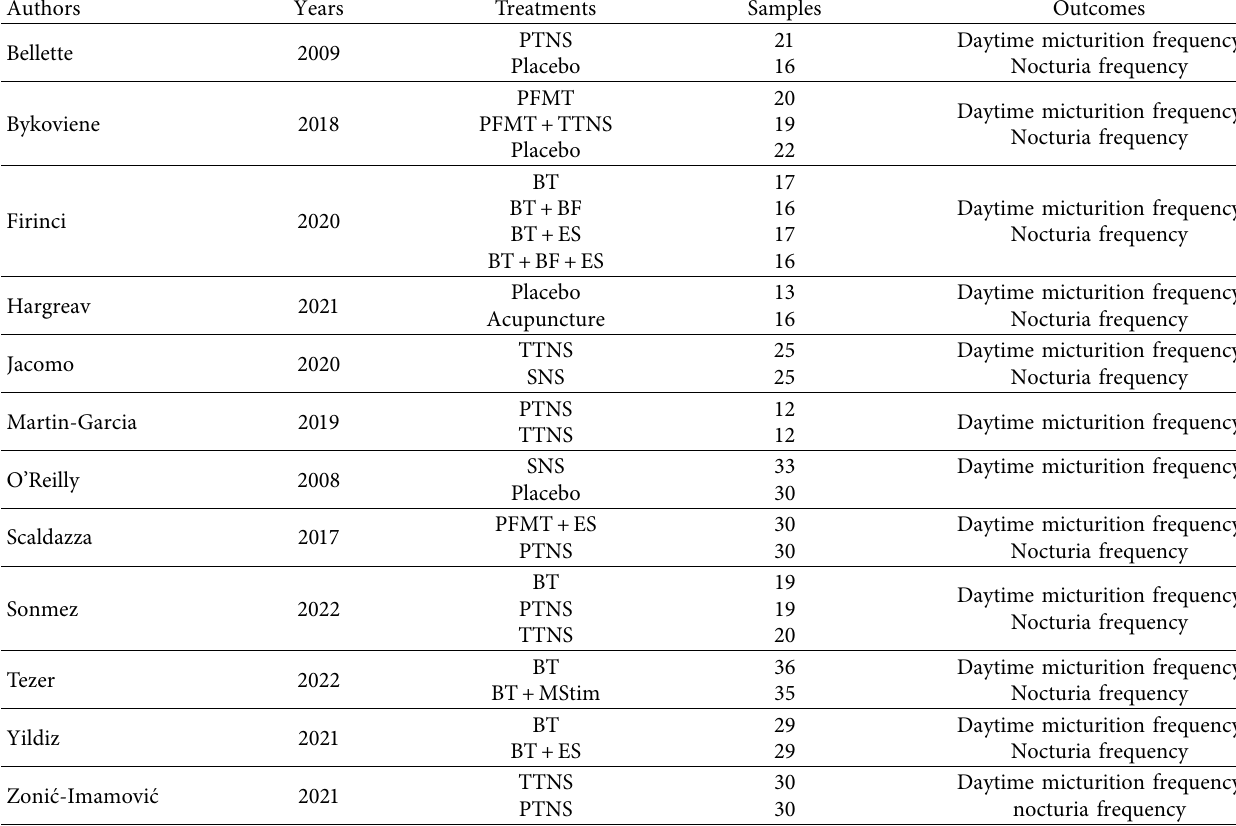
Table 1: Characteristics of enrolled studies.